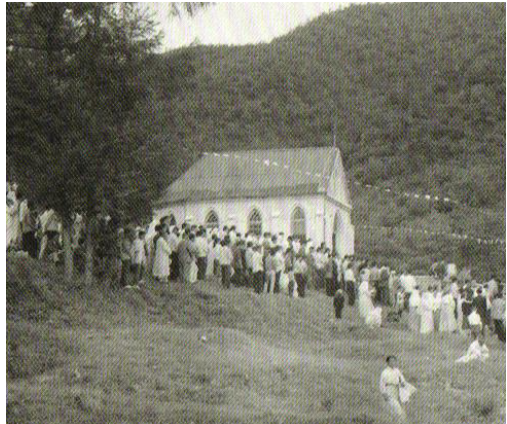
Figure 11. Image dated 26 September 1965 [source: Father Mark Kang Do-Young’s Collection of Letters , p. 581].